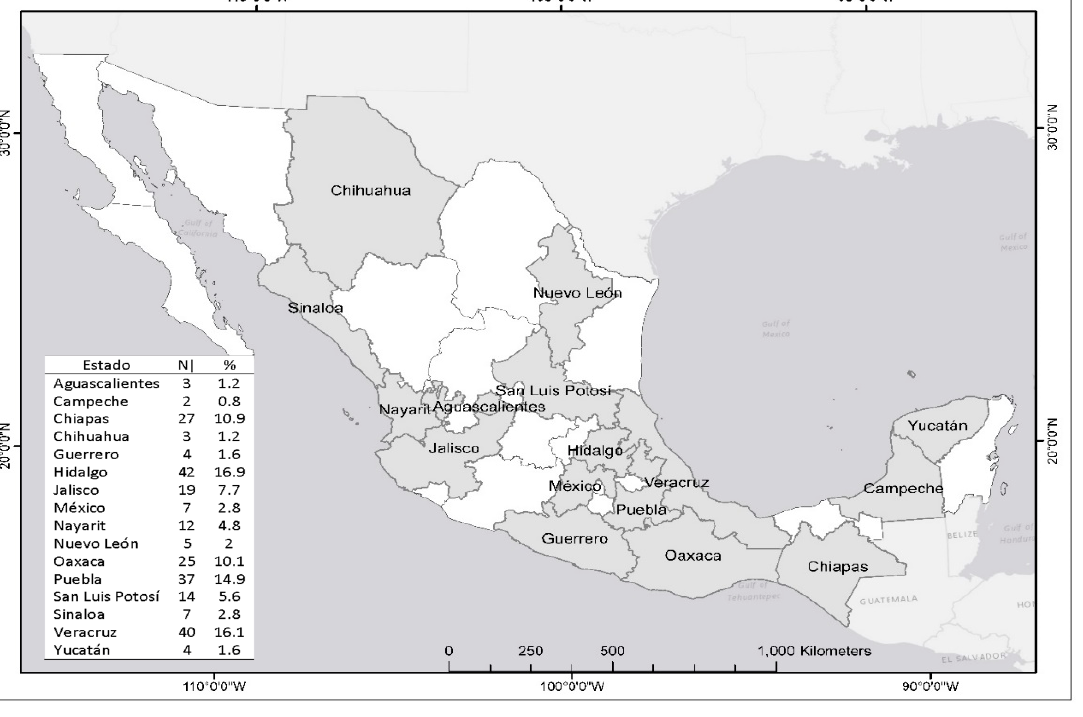
Figure 3. Aquaculture producers surveyed in Mexico (2019).